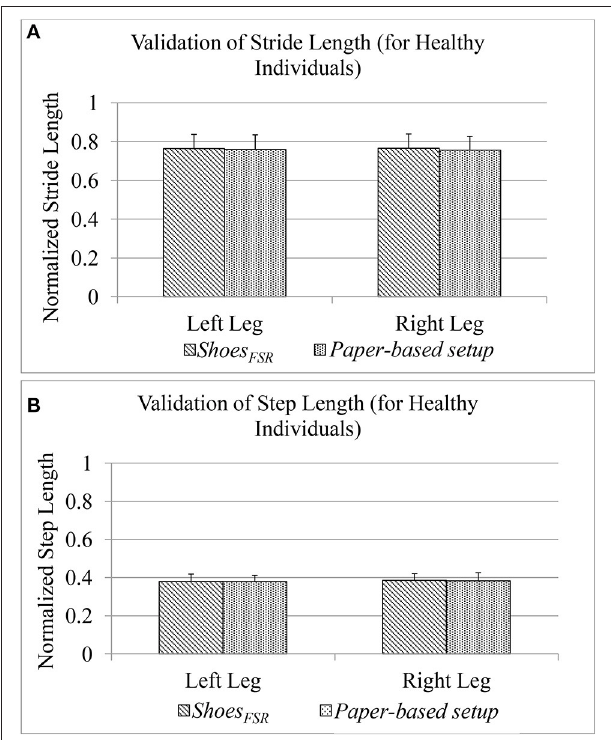
FIGURE 7 | (A) Comparison of Stride Length measured using Shoes FSR and paper-based setup for healthy participants; (B) Comparison of Step Length measured using Shoes FSR and paper-based setup for healthy